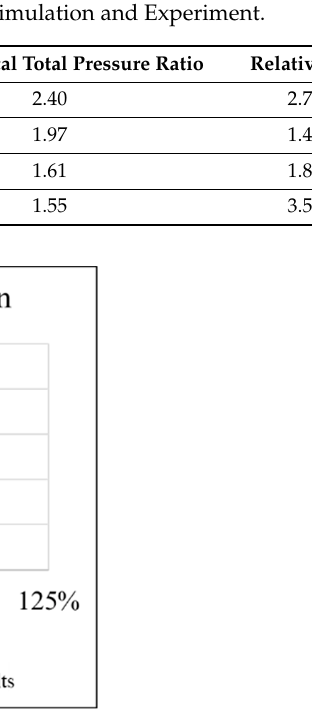
Figure 9. Comparison diagram of total pressure ratios of simulation and